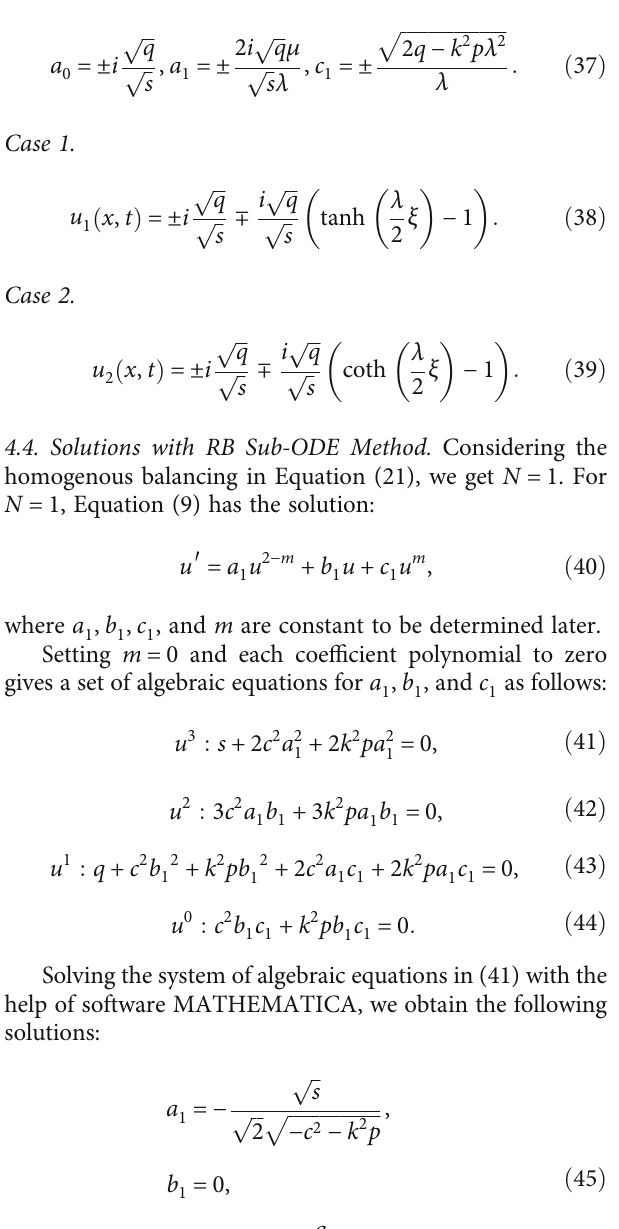
ffiffiffiffiffiffiffiffiffiffiffiffiffiffiffiffiffiffi p − c 2 − k 2 p